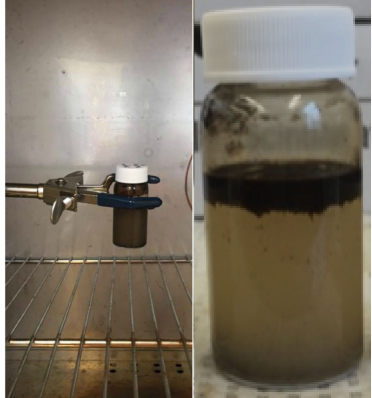
Figure 7. ( Left ): Vial containing 1 g of SBos oil sand (10 ± 1% bitumen content), 15 mg SNP- g - PMEO 2 MA (15%, DS 0.022), 0.5 M NaCl, 60 mg toluene, and 15 mL water attached to a tumbler arm in an oven at 45 ◦ C. ( Right ): Bitumen floating to the surface 24 h after the